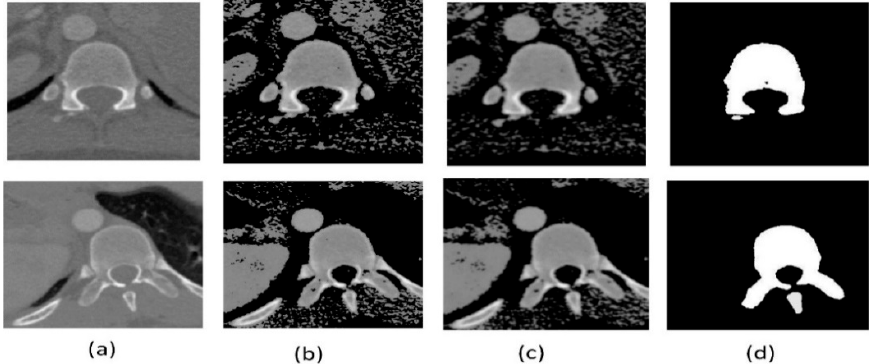
Figure 2. Example images of CT vertebrae used in the experiment: ( a ) sample raw images 512 × 512 pixels and ( b ) ground truths of selected samples, respectively.